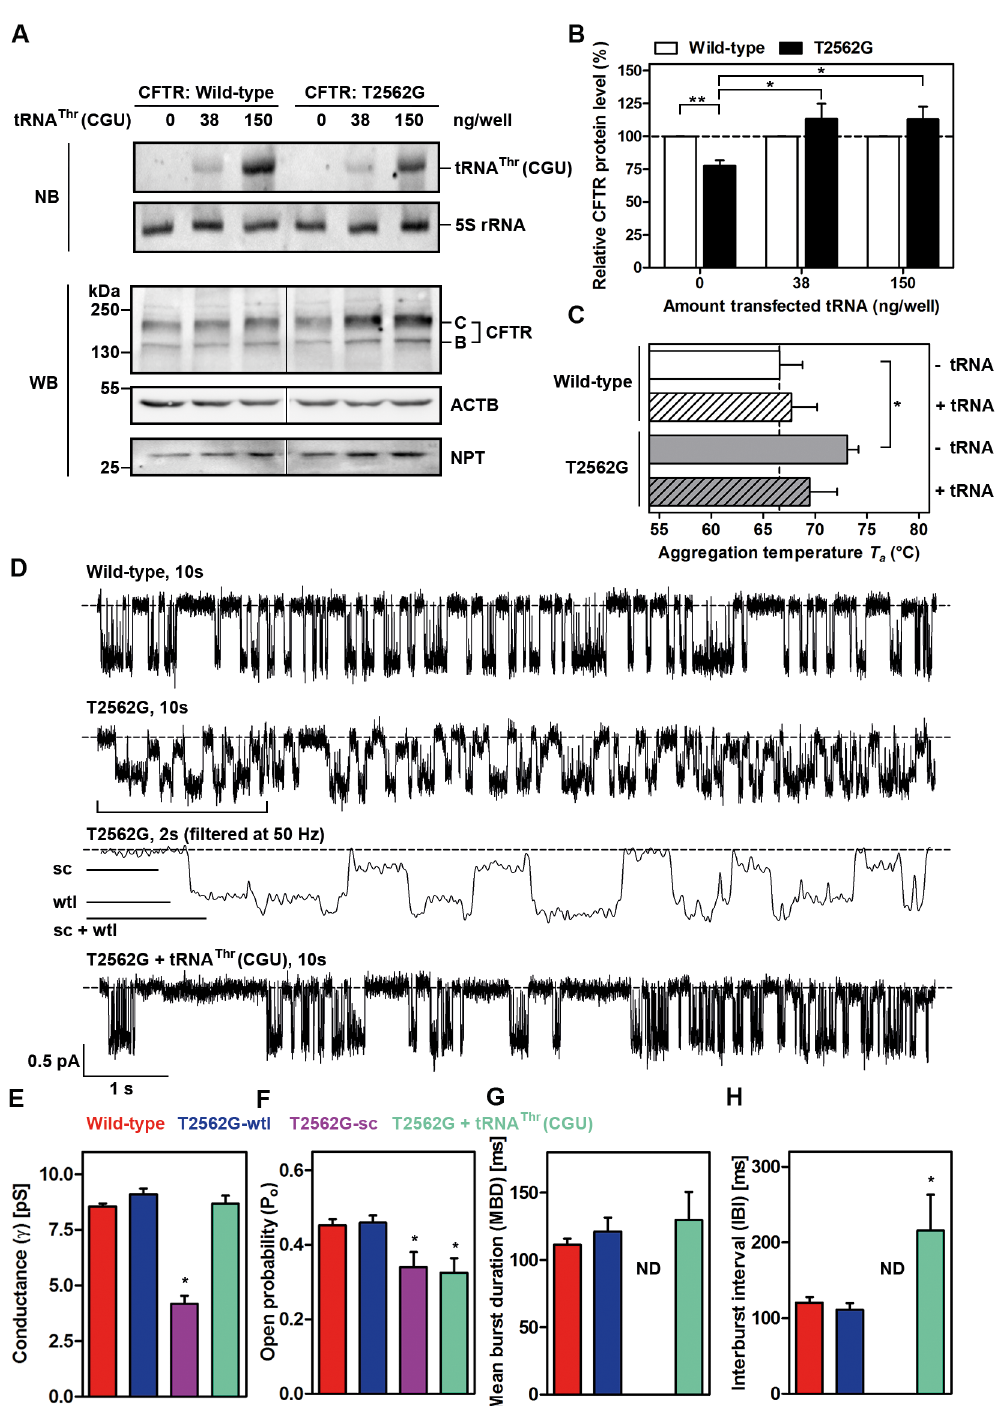
Fig 5. Increased tRNA Thr (CGU) levels ameliorate the expression and stability defects and abolish small- conductance openings of T2562G-CFTR. ( A ) Representative northernblot (NB) and WB analysisof HeLa cells cotransfectedwith tRNA Thr (CGU) and either wild-type or T2562G-CFTR. ( B ) Quantification of T2562G-CFTR from A (details in Fig 1B) and presented relative to those of wild-typeCFTR (set to 100%). Values are means ± SEM ( n = 5–7); * P < 0.05; ** P < 0.01. ( C ) Thermal aggregationpropensity assay upon cotransfection with 150 ng tRNA Thr (CGU) (+tRNA) comparedto untransfected controls (-tRNA). Values are means ± SEM ( n = 3–5); * P < 0.05 versus wild-type CFTR. ( D ) Representative single-channel recordingsof wild-type,T2562G-,